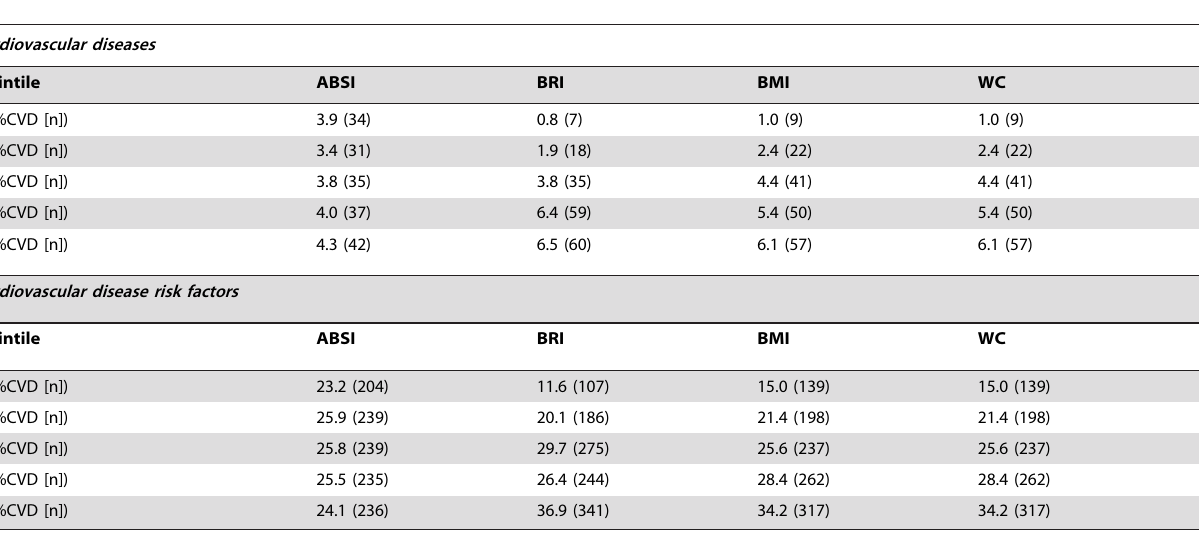
Table 3. Prevalence of CVD and CVD risk factors in quintiles of ABSI, BRI, BMI, and WC.